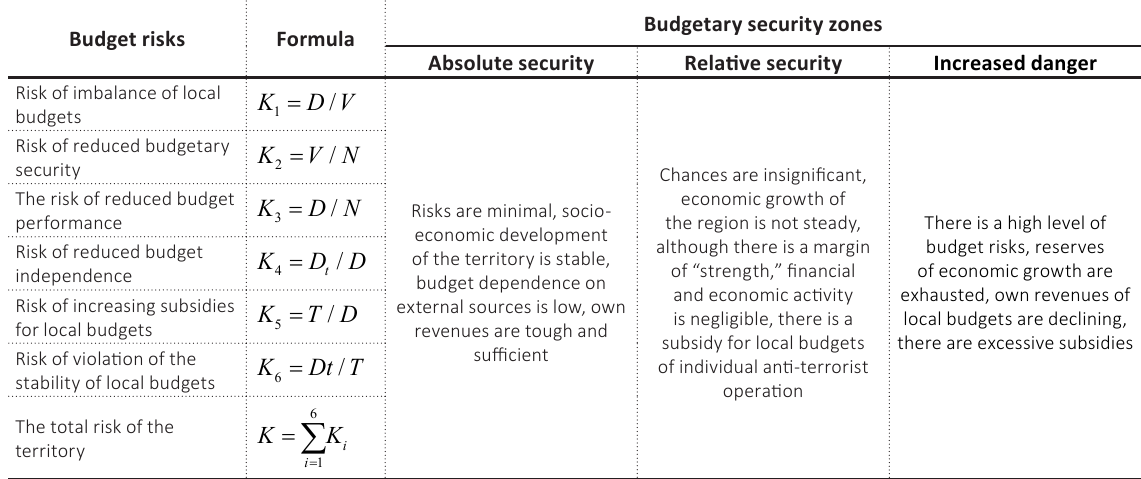
Table 2. Assessment indicators of budget risks and zones of budgetary security of regions (amalgamated hromada)